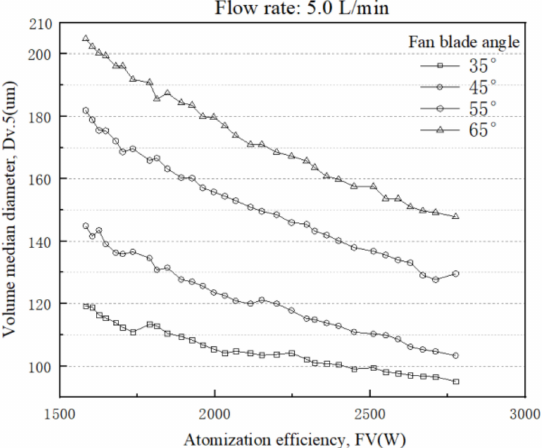
Figure 2. Relationship between power and droplet VMD for different atomizer fan blade angles at a flow rate of 5.0 L/min.